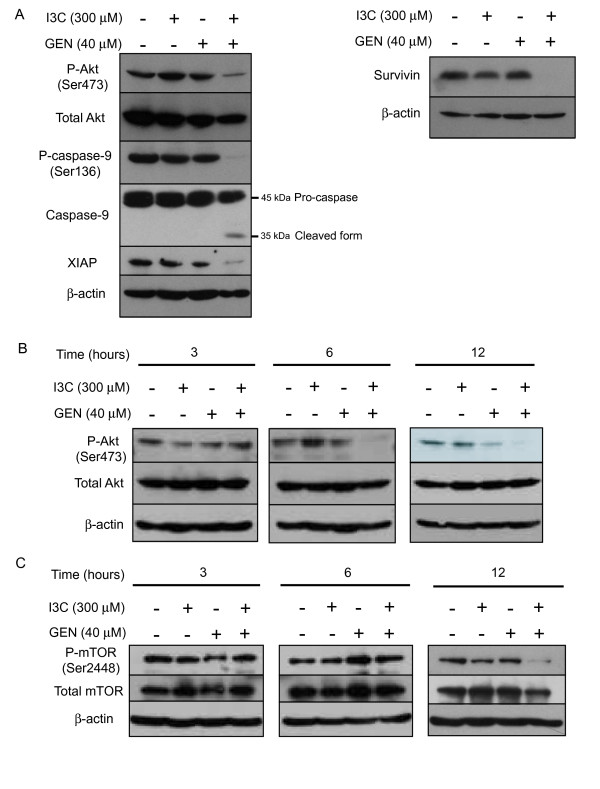
Expression of Akt and its downstream effectors following co-treatment. A, After 48 h of exposure to the indicated agents, cell lysates were subjected to western blotting using antibodies against phospho-Akt (Ser473), total Akt, phospho-caspase-9 (Ser136), caspase-9, XIAP or survivin. B and C, After exposure to the agents for the periods indicated, cell lysates were subjected to western blotting with anti-phospho-Akt (Ser473), anti-Akt (B), anti-phospho-mTOR (Ser2448), and anti-mTOR (C) antibodies. β-actin was used as a loading control. -, treated with DMSO. GEN, genistein.